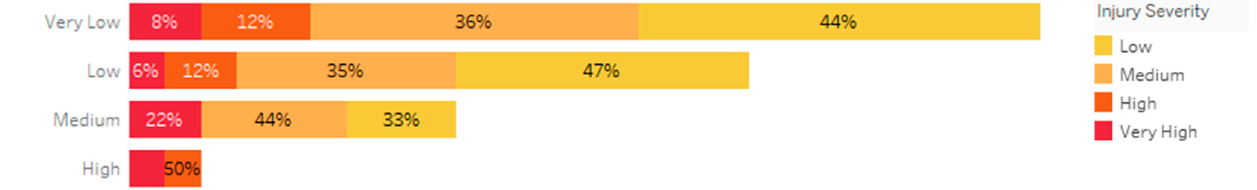
Figure 5. Percentage of injuries by IMS risk rating, coloured by actual insurance severity.